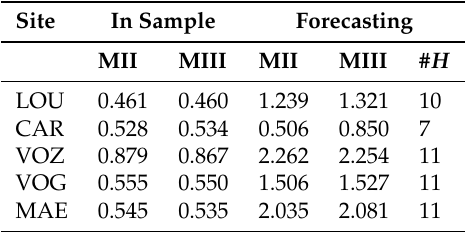
Table 6. Mean square error (MSE), in-sample and h -step-ahead forecast, for models MII and MIII. Site In